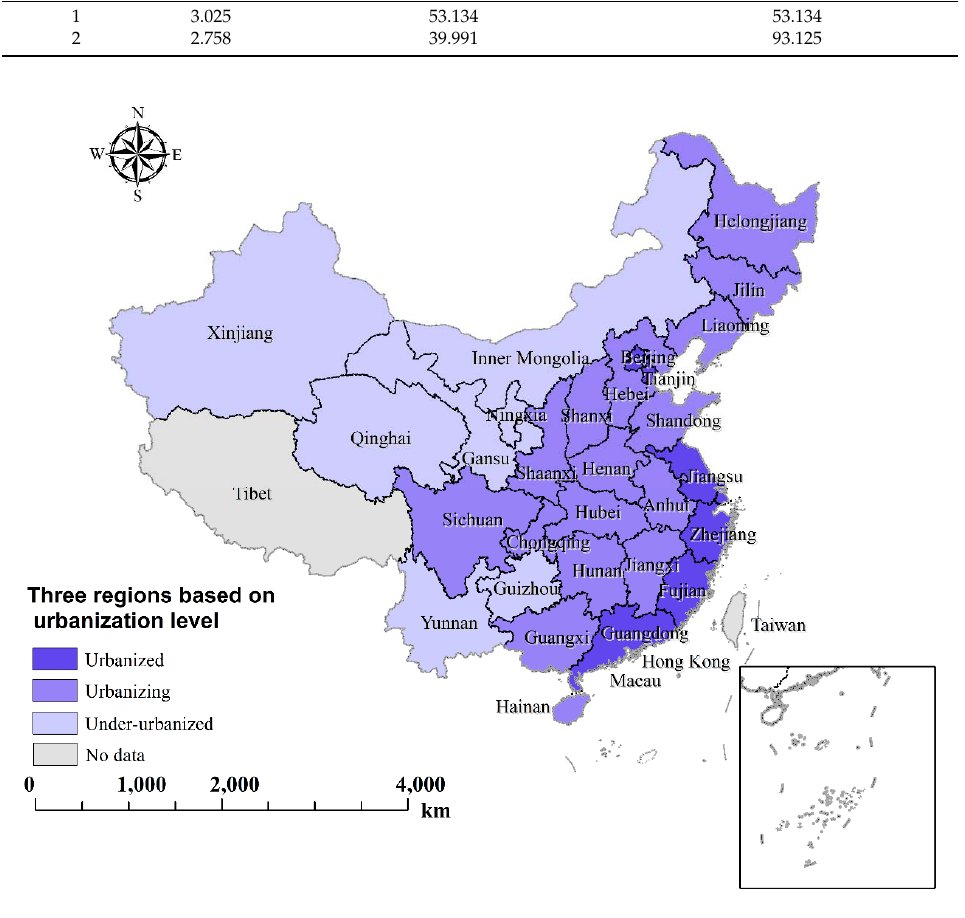
Figure 1. The three regions based on the degrees of urbanization (2015). Table 4. The scores and rankings of the degrees of urbanization of 30 provinces in